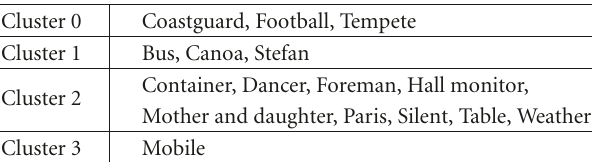
Figure 7: The distortions of the Mobile sequence for di ff erent num- bers of nonzero macroblocks ( N NZMB ) and SAD operations ( M Total ). Table 2: Results of clustering.